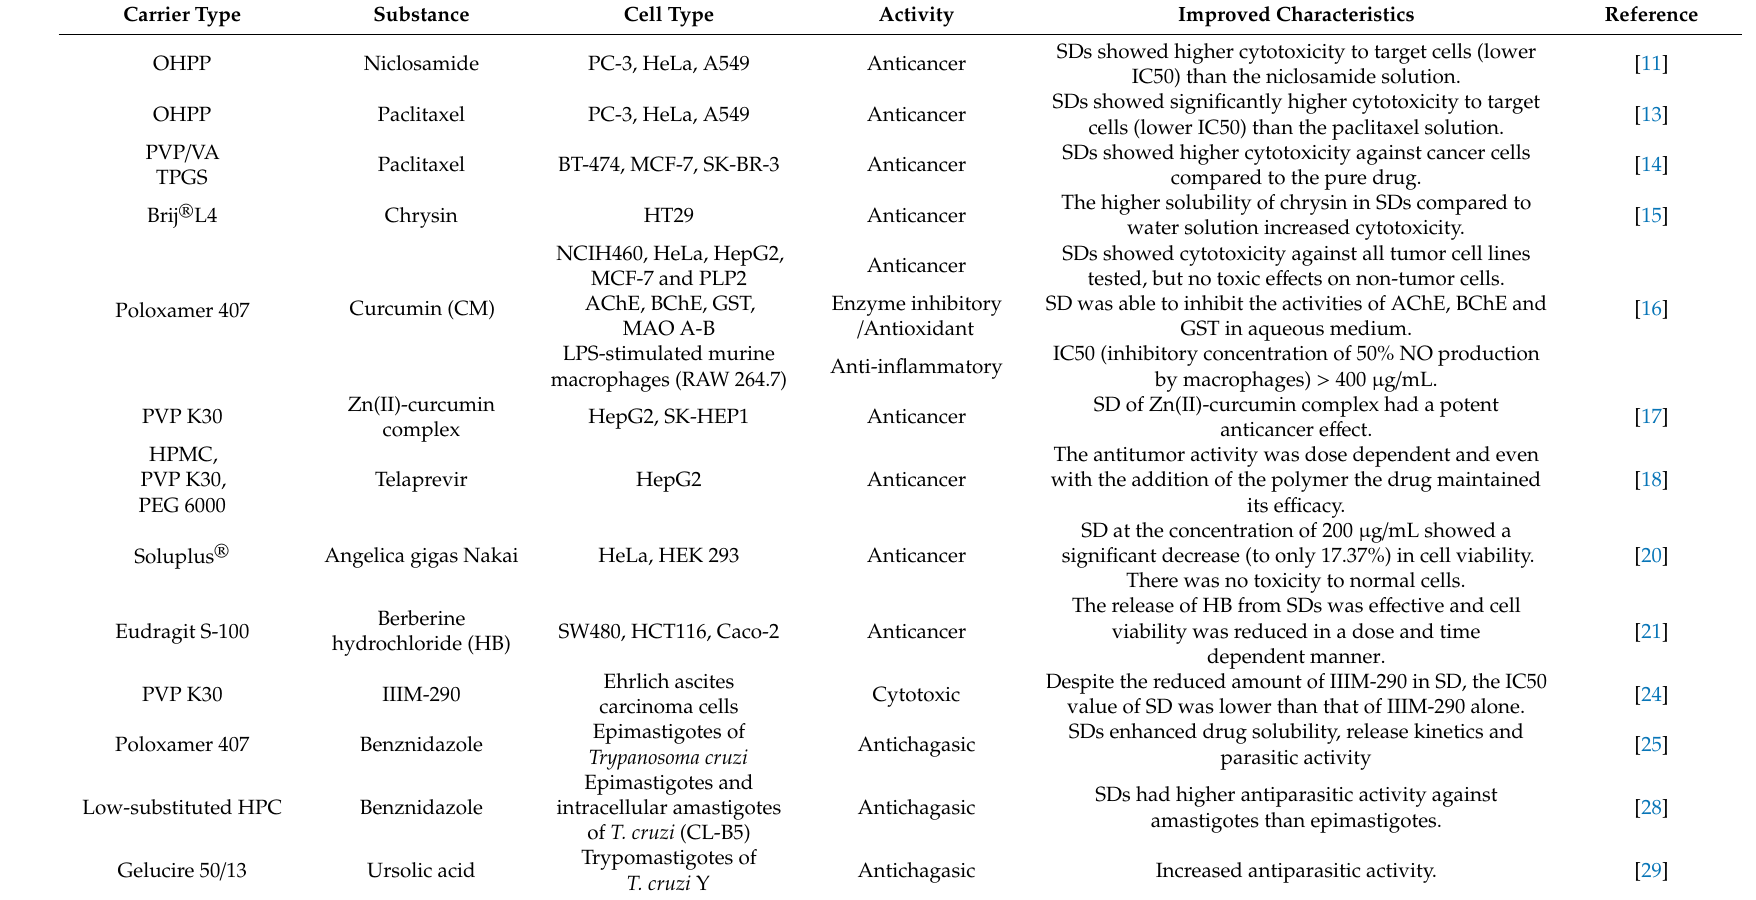
Table 1. In vitro studies on solid